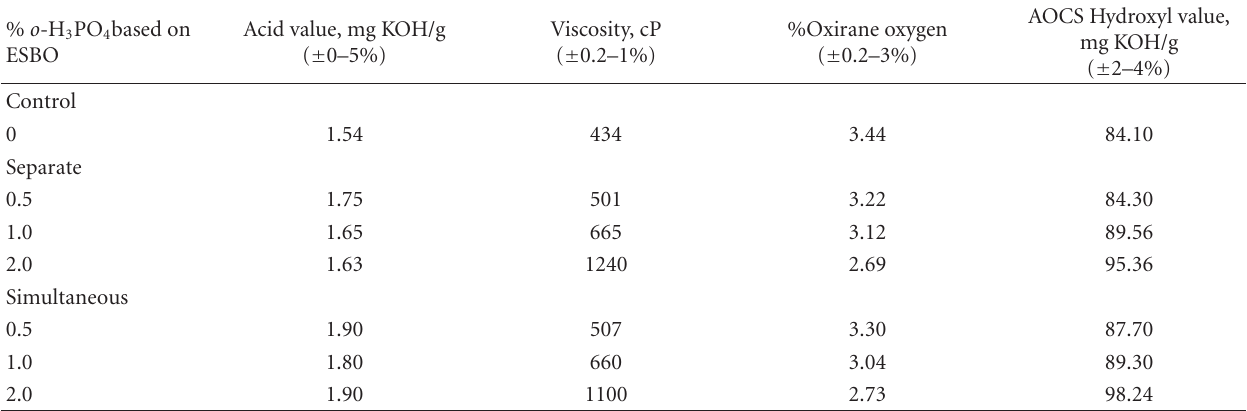
Table 2: Chemical properties of ESPs using two di ff erent mixing sequences. The Gardner color indices of the samples range from1 to 3. All reacted samples composition: 1:1 by wt ESBO and CO. “Separate” indicates that acid reaction was done first before alcohol addition while “Simultaneous” that indicates acid and alcohol reactions were done at the same time.